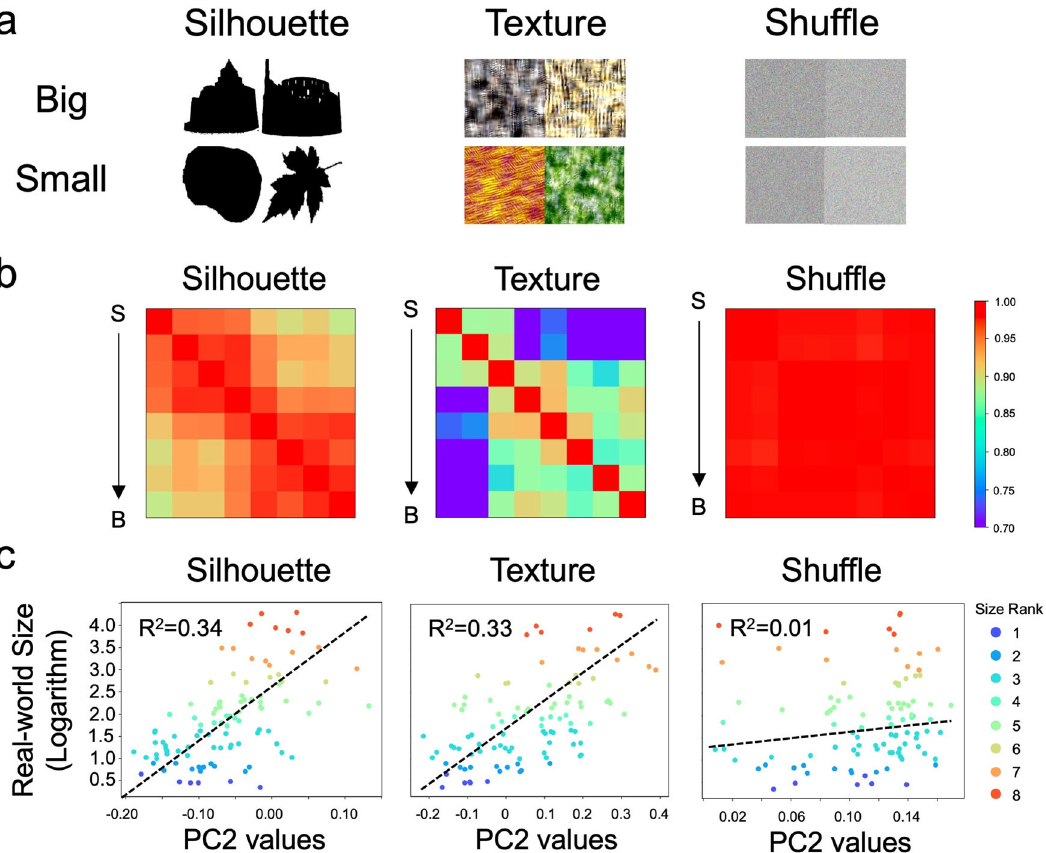
Fig. 5 The factors of objects ’ shape and texture in inferring objects ’ size. a Image examples of silhouette, texture, and shuf fl e conditions. b The RSM of Conv4 ’ s responses to objects ’ size. The sensitivity to the size was found when either silhouettes or textures were presented, but not when shuf fl e images were presented. c The common logarithm mapping between PC2 and objects ’ size was found in both silhouettes and textures, but not in shuf fl e conditions. S small objects, B big